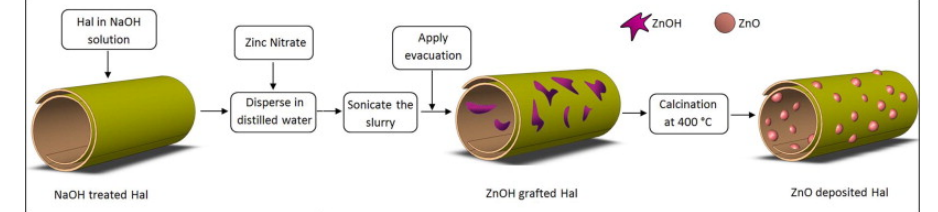
Figure 6. Schematic representation of the deposition process of ZnO nanoparticles (ZnONPs) onto HNTs. Reproduced with permission from [93].